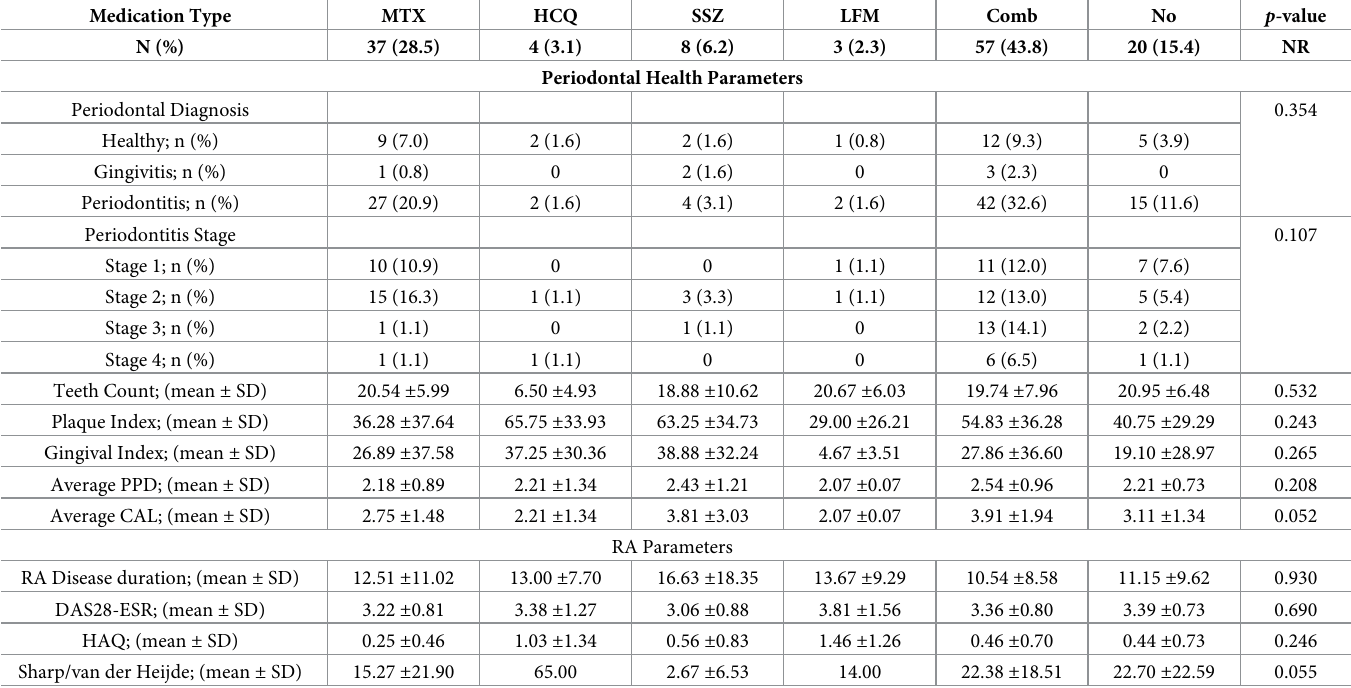
Table 5. Periodontal health parameters and RA parameters according to the DMARDs